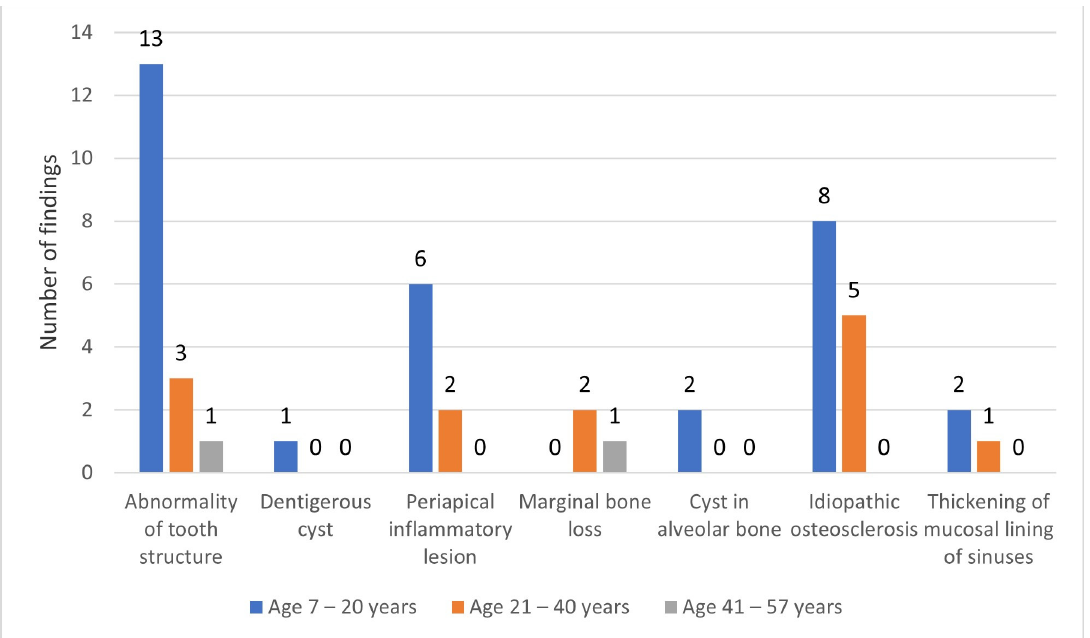
Figure 2. Frequency of incidental pathologic findings by age category .